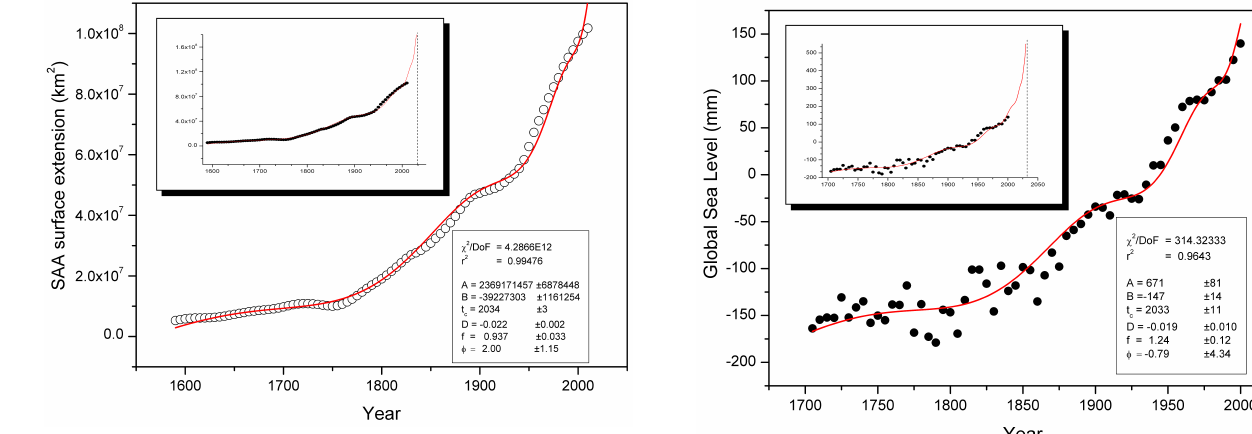
Fig. 2. Global sea level (GSL) rise and its best log-periodic fit with Eq. (5). The critical time (2033 ± 11yr indicated by the vertical dashed line in the smaller picture) within the given error is the same as that estimated for the SAA. In the inset table, DoF are the degrees of freedom and r is the correlation coefficient of the nonlinear fit; for the other fitting parameters see the